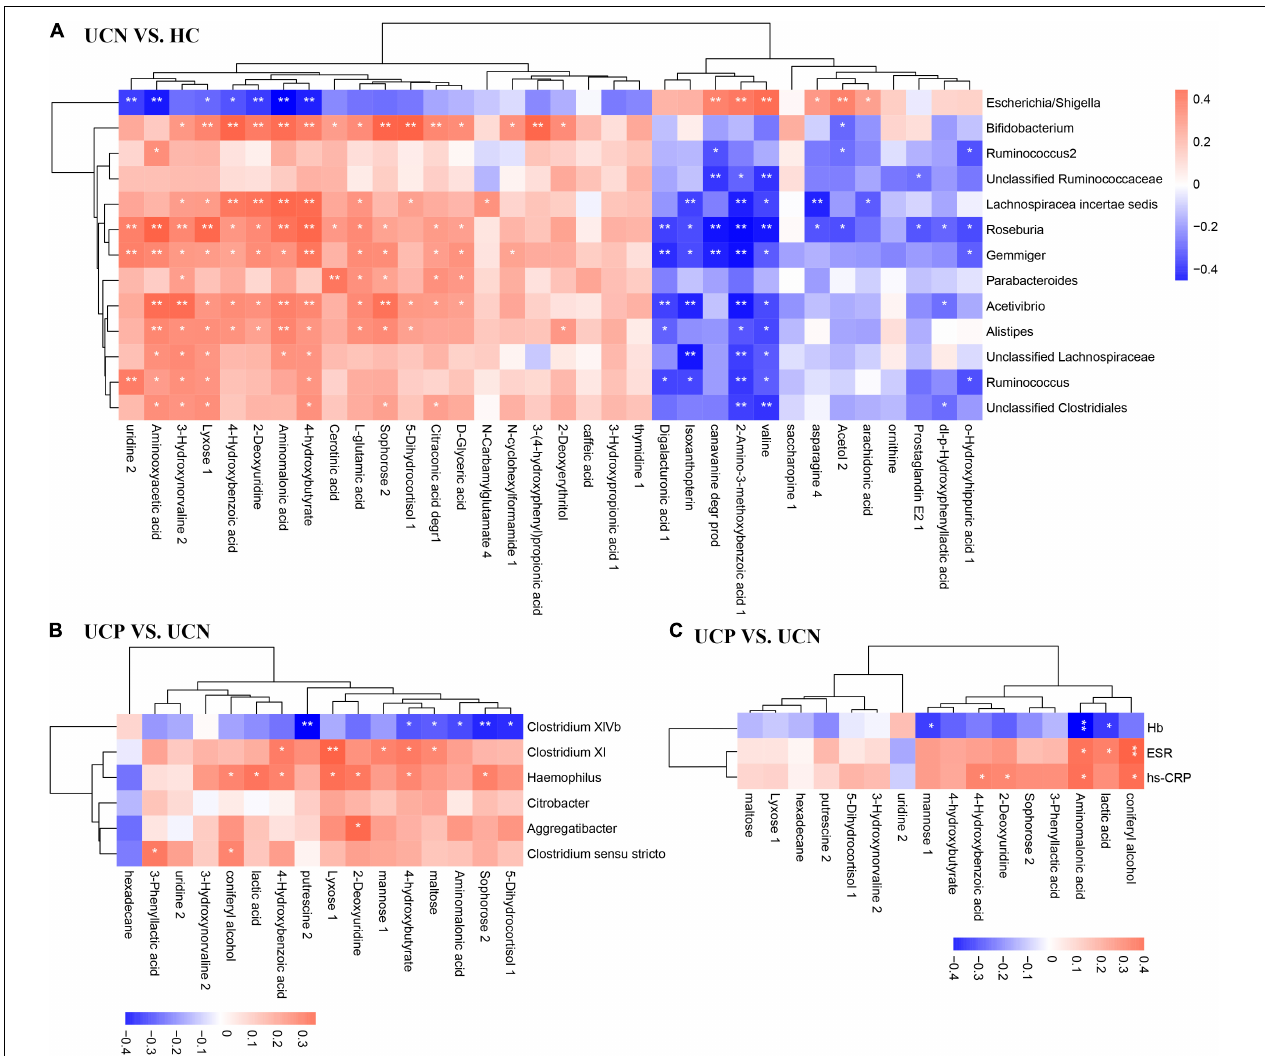
FIGURE 5 | Correlation analysis of differential gut microbiota genera (relative abundance > 0.2%) and differential metabolites between the HC and UCN groups (A) , and between the UCN and UCP groups (B) . (C) Correlation analysis of differential metabolites and laboratory tests between the UCN and UCP groups. * p < 0.05; ** p < 0.01; HC, healthy control group; UCN, ulcerative colitis with negative Clostridioides difficile test results; UCP, ulcerative colitis with positive Clostridioides difficile infection.